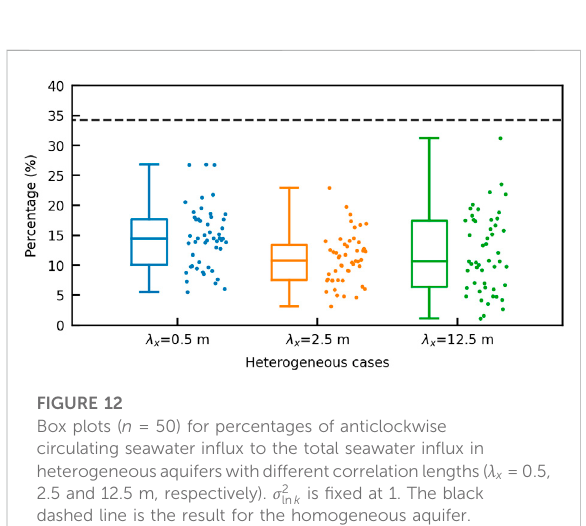
FIGURE 12 Box plots ( n = 50) for percentages of anticlockwise circulating seawater in fl ux to the total seawater in fl ux in heterogeneousaquiferswithdifferentcorrelationlengths( λ x =0.5, 2.5 and 12.5 m, respectively). σ 2 ln k is fi xed at 1. The black dashed line is the result for the homogeneous